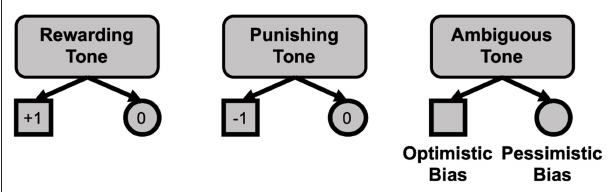
FIGURE 4 | Schematic representation of the ambiguous interpretation test. Choosing the square following the rewarding tone gave 1 point; choosing the circle following the rewarding tone did not affect the score; choosing the square following the punishing tone took 1 point away; choosing the circle following the punishing tone allowed the respondent to avoid losing 1 point; choosing the square following the ambiguous tone indicated optimistic bias; and choosing the circle following the ambiguous tone indicated pessimistic bias.